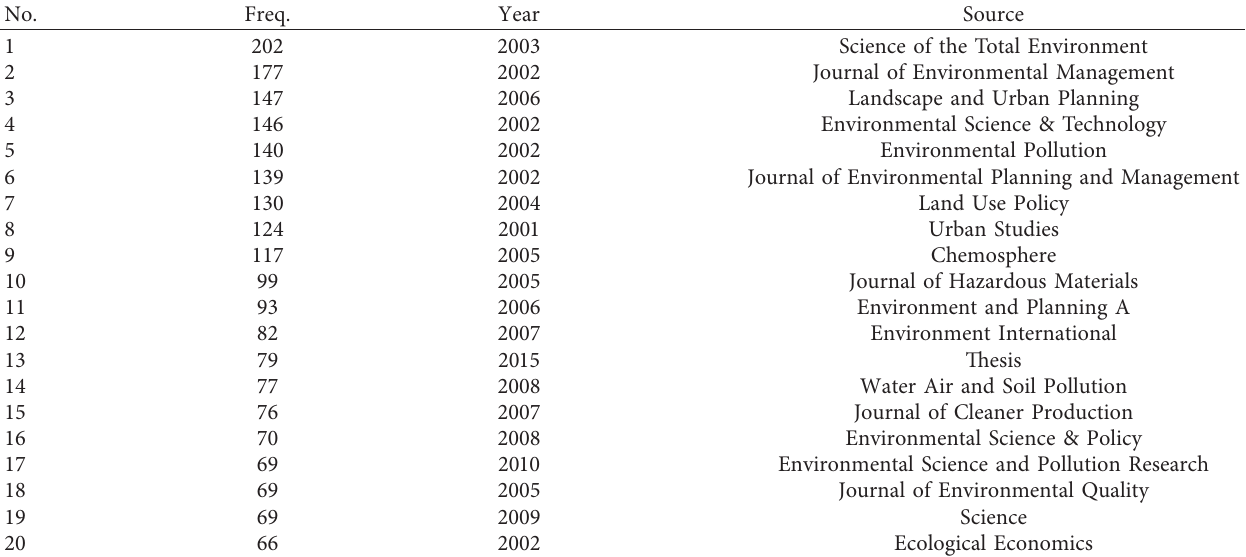
Table 4: The top 20 journals in brownfield research, according to the 773 publications.